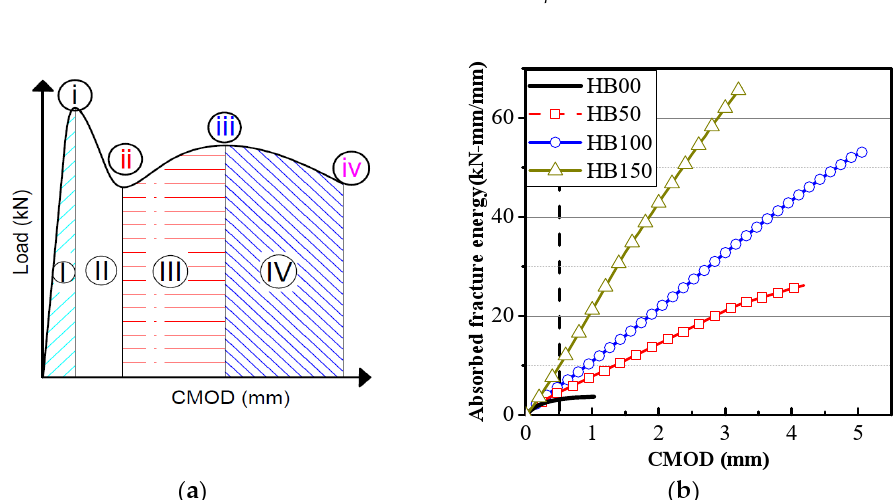
Figure 3. The interrelationship between concrete matrix, fibers, and reinforcement components in the determination of shear capacity [37]. V uf = fibers contribution, V uc = Concrete matrix contribution, V us = Stirrups Contribution.